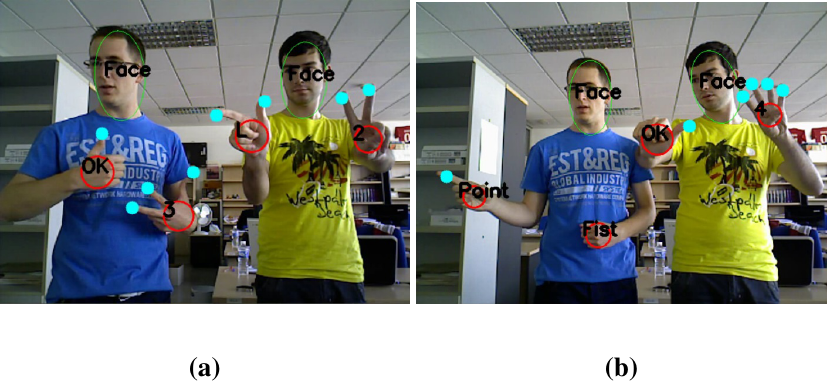
Figure 12. Examples of the appearance of two different users of the system simultaneously.